Question: Write a single sentence explaining what this figure depicts.
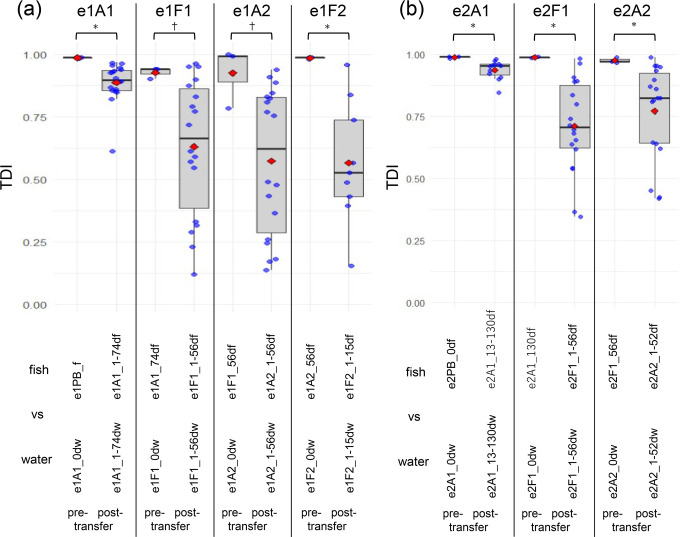
Answer: Theta dissimilarity index (TDI; 1 − thetaYC) values comparing microbial community dissimilarity between fish skin and environmental water across translocation events in ( a ) e1 and ( b ) e2. TDI values were calculated by pairing fish skin samples with the corresponding environmental water samples from the destination environment. After transfer, TDI values decreased compared to pre-transfer conditions, indicating that the fish skin microbiota became less dissimilar to the destination water microbiota. Importantly, this reduction demonstrates that post-transfer fish skin microbiota is more similar to the destination water microbiota than to the pre-transfer water microbiota, reflecting a directional shift in community structure rather than complete similarity between the communities. Blue circles represent individual TDI values, red diamonds indicate means, and black lines indicate medians. * P < 0.05, † P < 0.1.